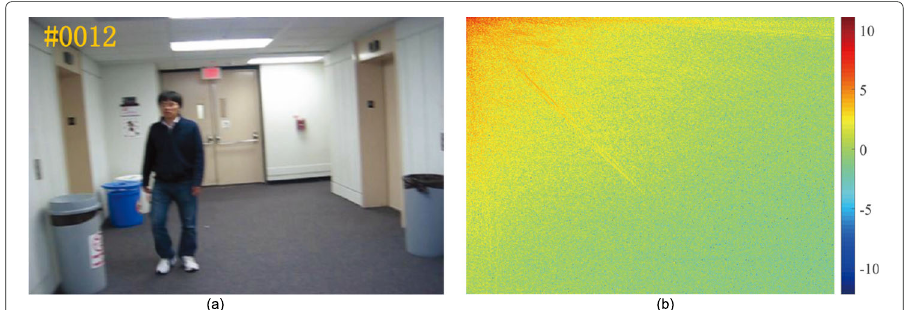
Fig. 2 Video frame and its matrix of discrete cosine transform coefficients. a Frame 12 of the BlurBody video sequence. b Matrix of discrete cosine transform